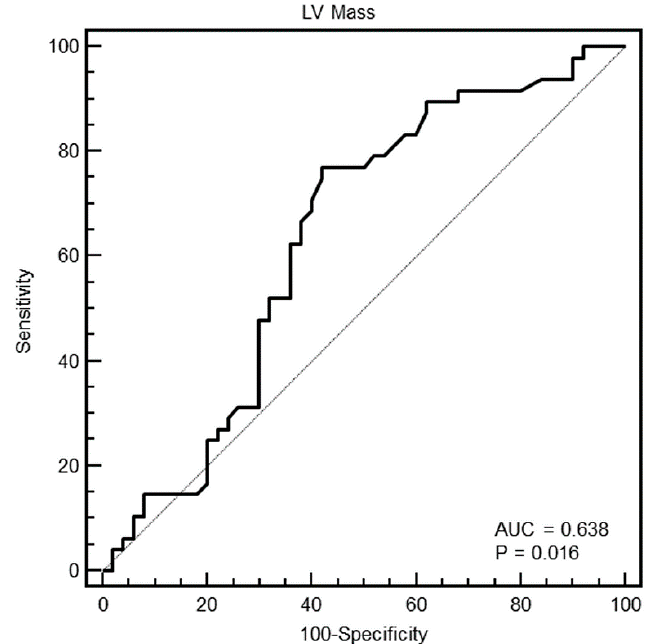
Figure 3. Receiver operating characteristic (ROC) curves of the LV mass for identification of patients with HCM in the whole population. The grey line represents the AUC = 0.5; black line is the ROC curve of LV mass.